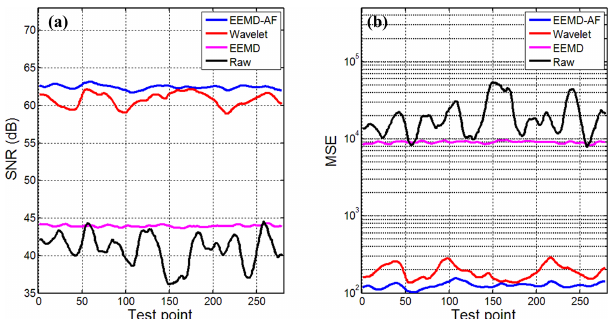
Figure 4. Comparison of SNR and MSE profiles produced by the datasets by different methods along with test point. (a) The contrast between SNR on different datasets; (b) the contrast between MSE on different datasets. The vertical coordinates are changed to loga- rithmic format in order to show a wide range of changes in MSE.